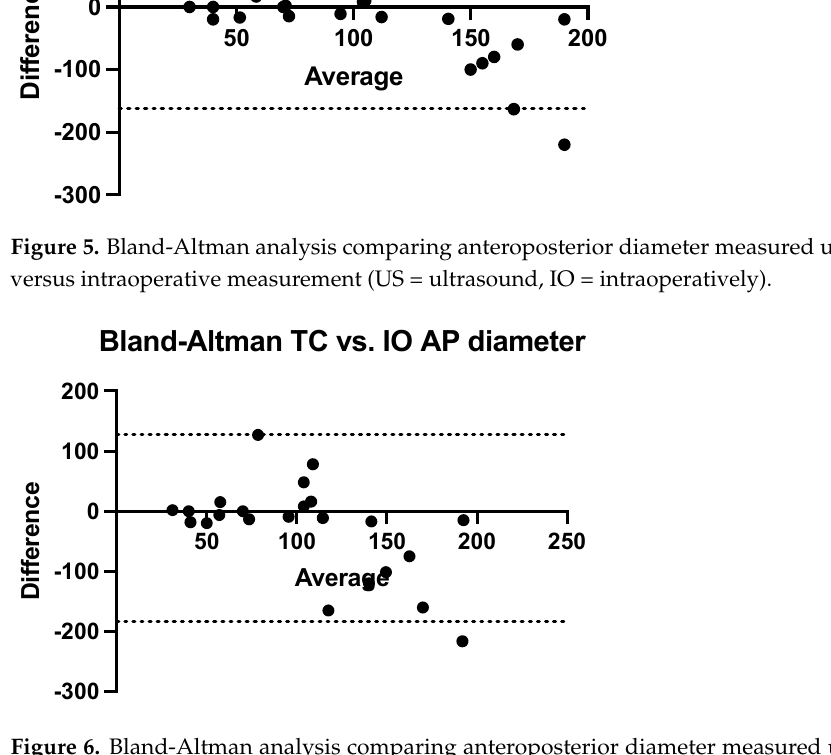
Figure 7. Bland-Altman analysis comparing transverse diameter measured using ultrasound ver- sus intraoperative measurement (US = ultrasound, IO = intraoperatively). Figure 8. Bland-Altman analysis comparing anteroposterior diameter measured using computed tomography versus intraoperative measurement (TC = computed tomography, IO = intraopera- tively). In order to increase the accuracy of the statistical analysis regarding the invasion of nephroblastomas, this time we used as a reference the histopathological examination of the tumour, which includes three essential characteristics: rupture of the renal capsule, invasion of the pelvis and ureter and invasion of the renal vein. Ultrasonography failed to detect any case of rupture of the renal capsule among the 10 objectified in the histopathological examination. Instead, the computer-tomographic examination still highlighted five of these cases (Figure 9, Table 2). Additionally, ultra- sonography failed to detect any case of invasion of the pelvis and ureter among the six existing in our cohort and computed tomography highlighted five of them with great accuracy (Figure 10. Regarding the vascular invasion in the renal vein, 4 of the 11 histo- pathological cases were detected by ultrasonography and computed tomography re- vealed 5 cases. However, the distribution frequency of the detection of this vascular in- vasion is statistically significantly different ( p = 0.02) from the histopathological one, which makes ultrasonography a poor diagnostic method (Figure 11).